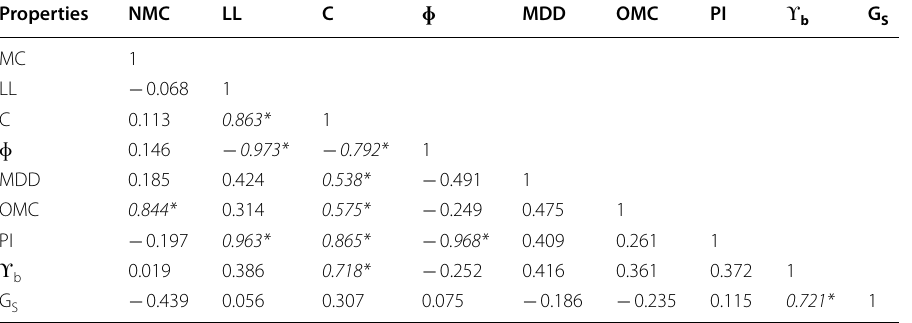
Significant values are in italics * Correlation is significant at the 0.05 level (2-tailed)